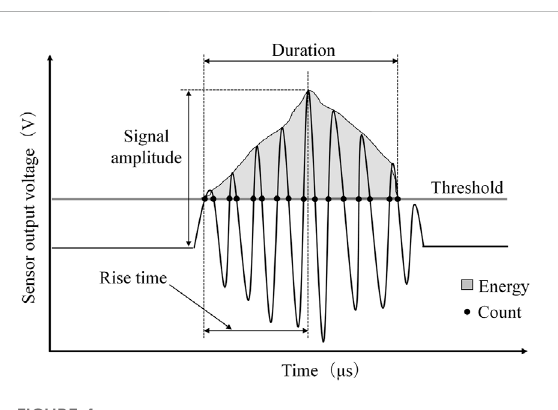
FIGURE 4 Schematic showing some parameters of an AE waveform.